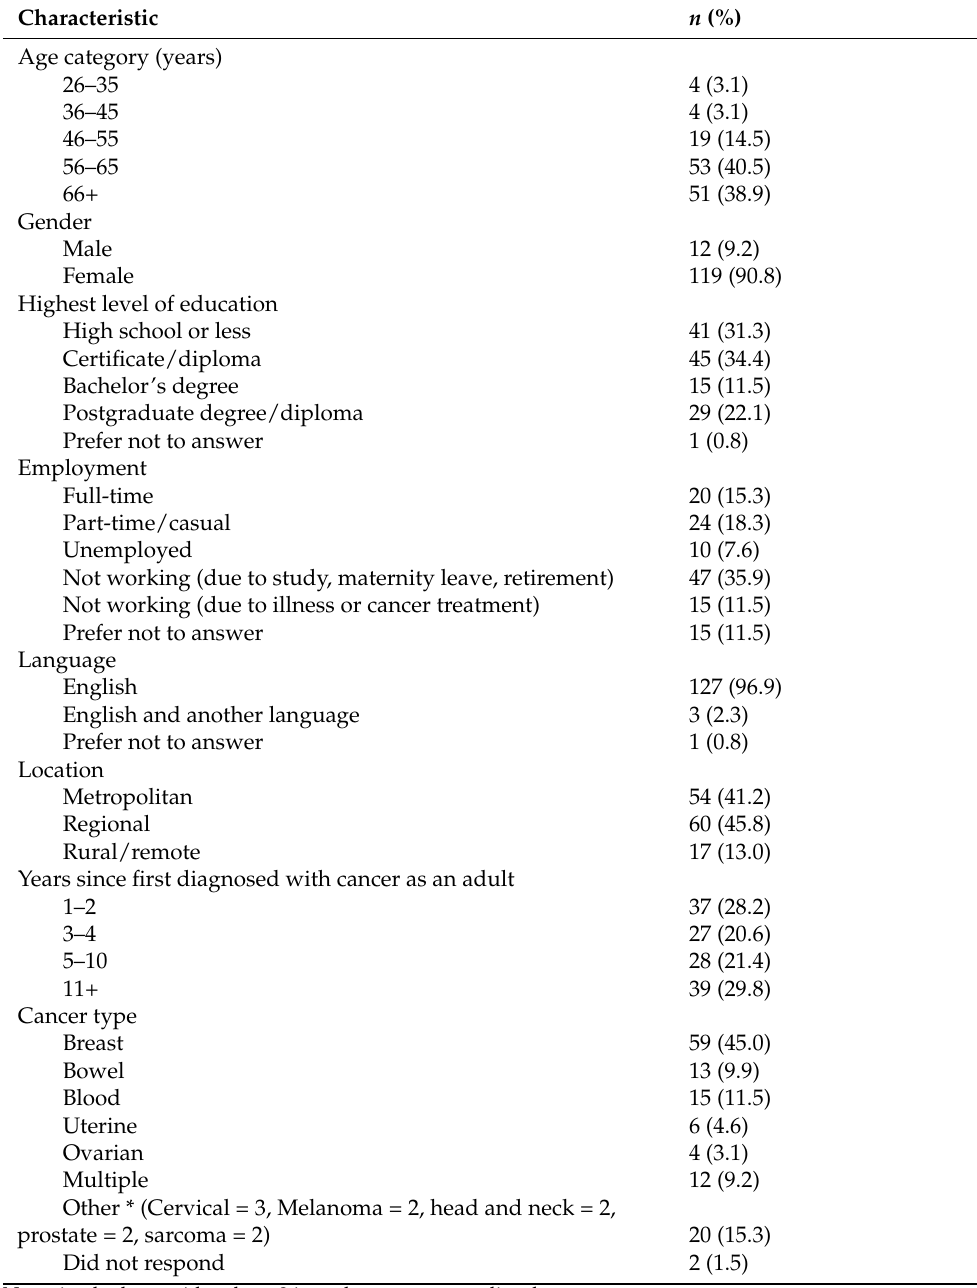
Table 1. Demographic characteristics of participants included in the study ( N = 131).